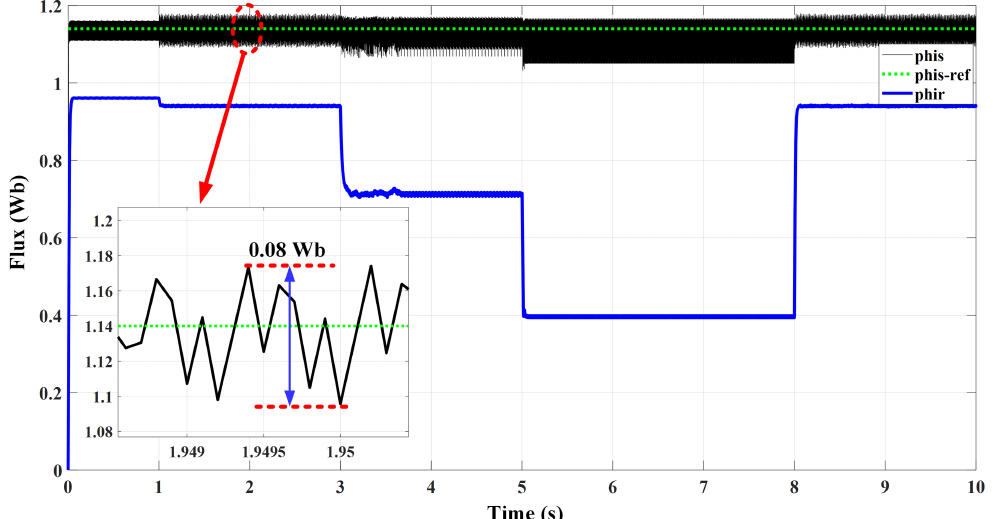
Figure 7. The DTSFC with successive steps of torque references for testing stator and rotor flux responses.